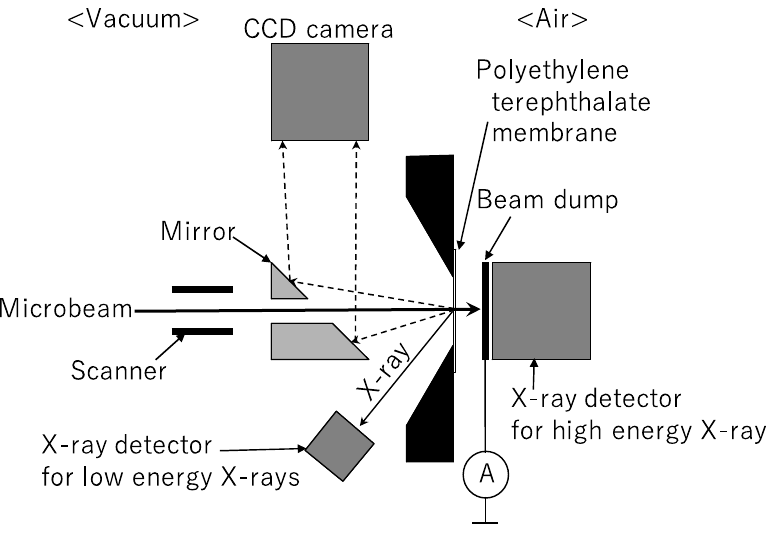
Figure 17. A cross-sectional view of the in-air micro-PIXE (particle induced X-ray emission)